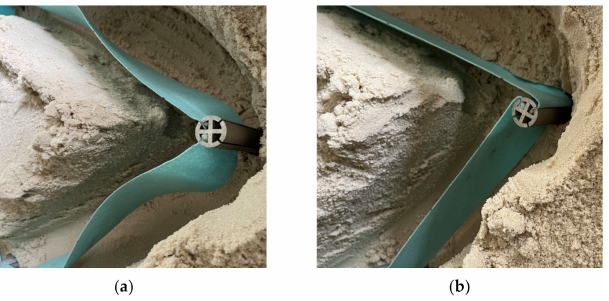
Figure 13. Tension of the nonwoven fabric ( a ) before and ( b ) after rotation of the supporting